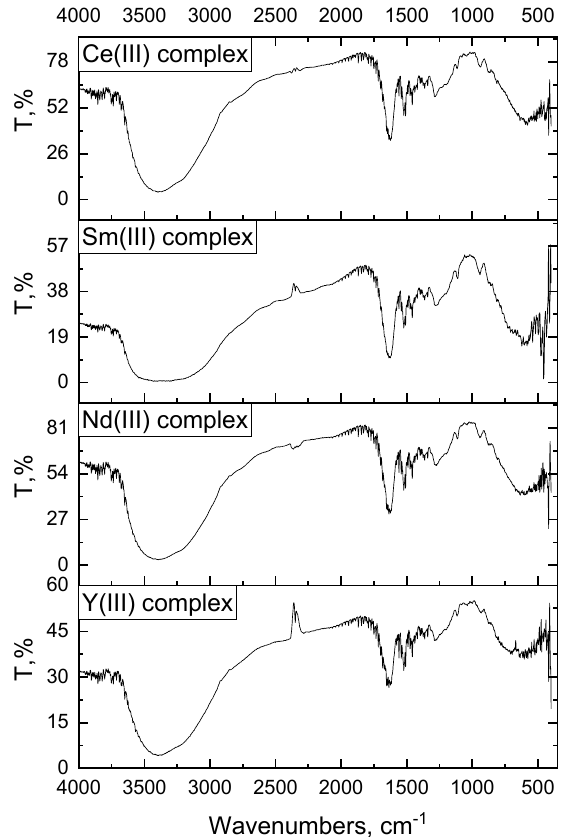
Figure 2. Infrared spectra of [Y 2 (Adr) 2 (H 2 O) 8 ]Cl 3 · 8H 2 O, [Ce(Adr) 2 (H 2 O) 2 ]Cl 3 · 10H 2 O, [Nd(Adr) 2 (H 2 O) 2 ]Cl 3 · 6H 2 O, and [Sm(Adr) 2 (H 2 O) 2 ]Cl 3 · 12H 2 O adducts.